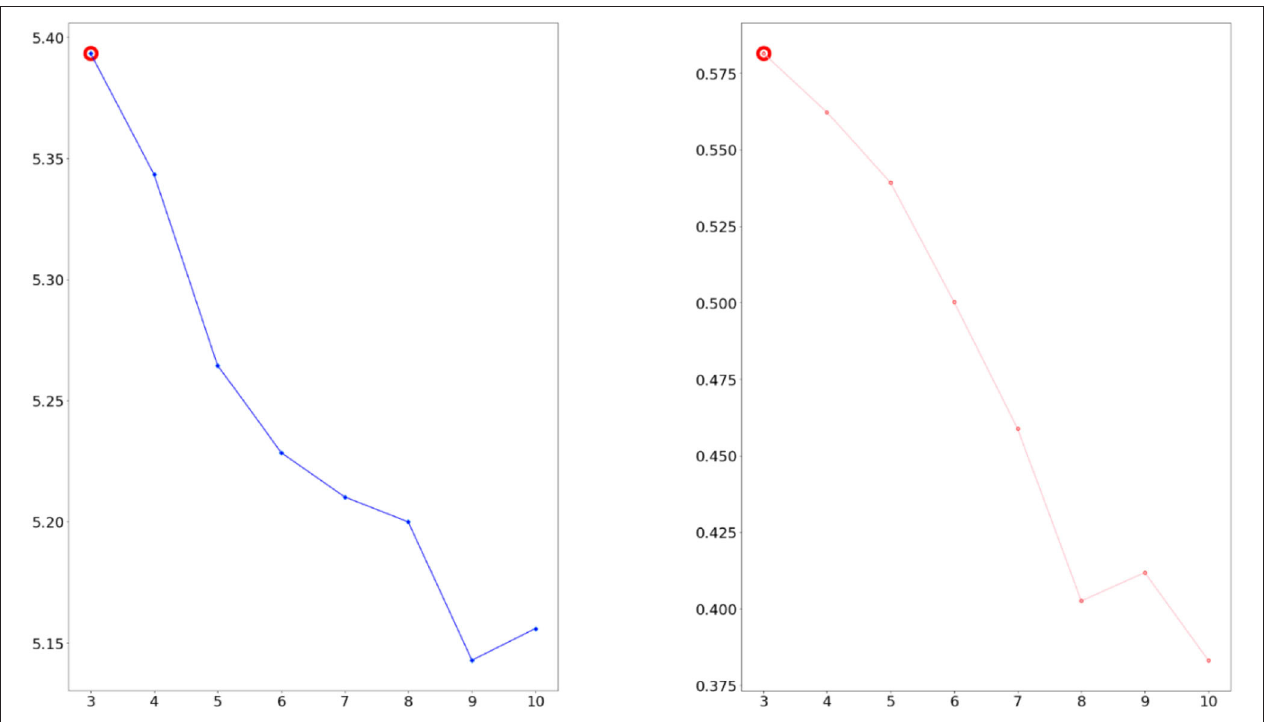
FIGURE 5 | Calculated perplexity (left) and C V (right) for selecting optimal number (2016–2018 dataset).